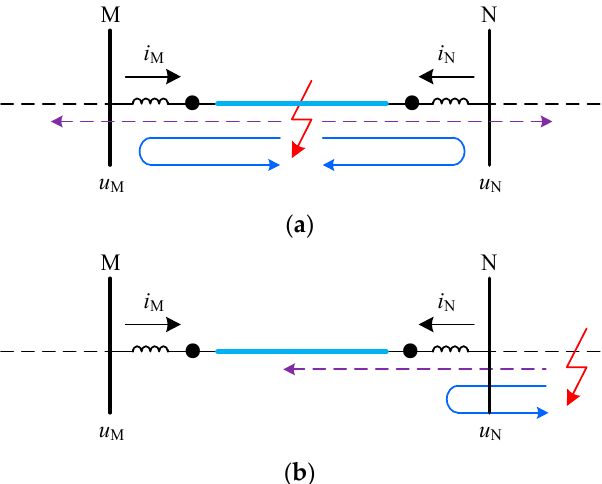
Figure 11. Fault section identification: ( a ) Fault TW for internal fault; ( b ) Fault TW for external fault.